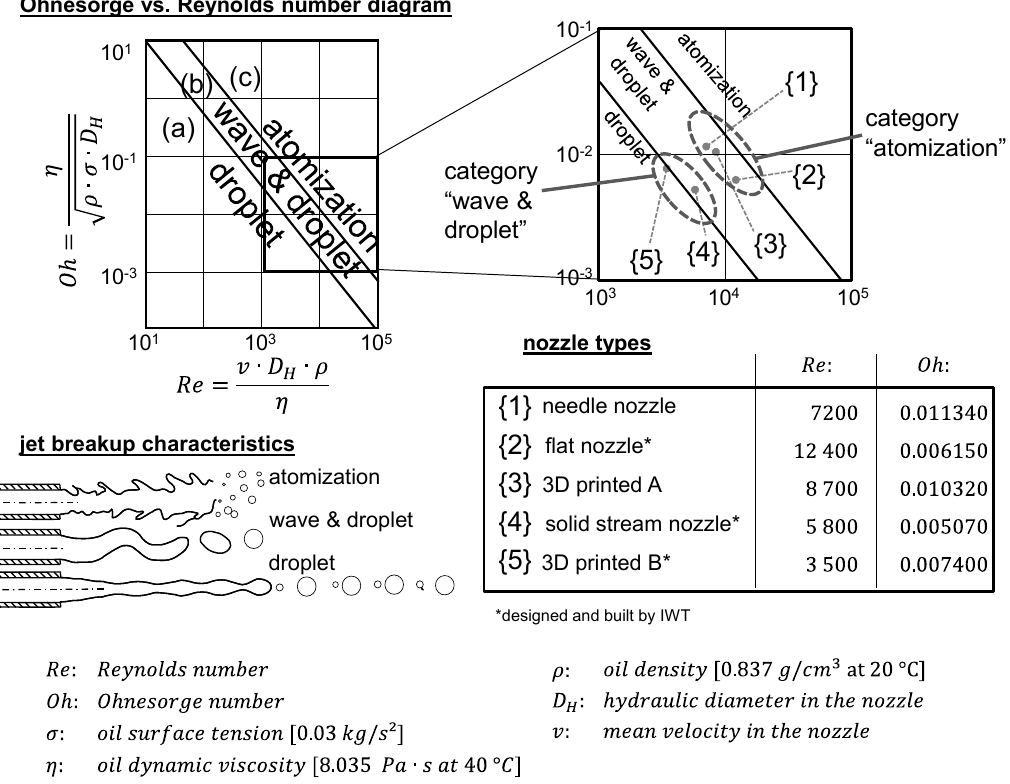
Figure 1. Ohnesorge vs. Reynolds number diagram and jet breakup characteristics (after [10]).